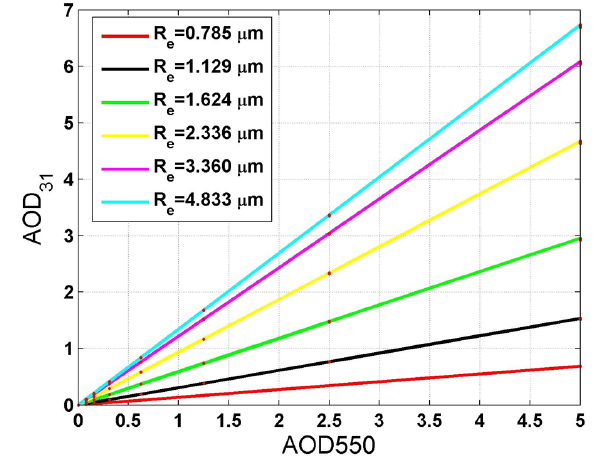
Fig. 4. AOD of the MODIS TERRA band 31 vs AOD at 550nm (in- put MODTRAN parameter). The red points contain all the MOD- TRAN simulations (12 monthly profiles, 4 plume altitudes, and 12 viewing angles). The coloured lines are the linear interpolation for the different effective ash particle radius ( R e )